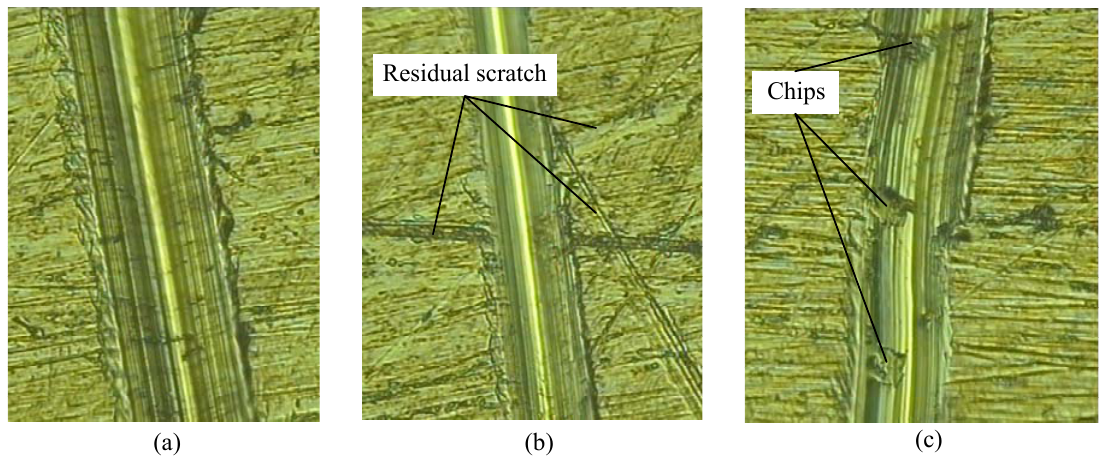
Figure 12. Residual scratch morphologies of the Zr-based bulk metallic glass.